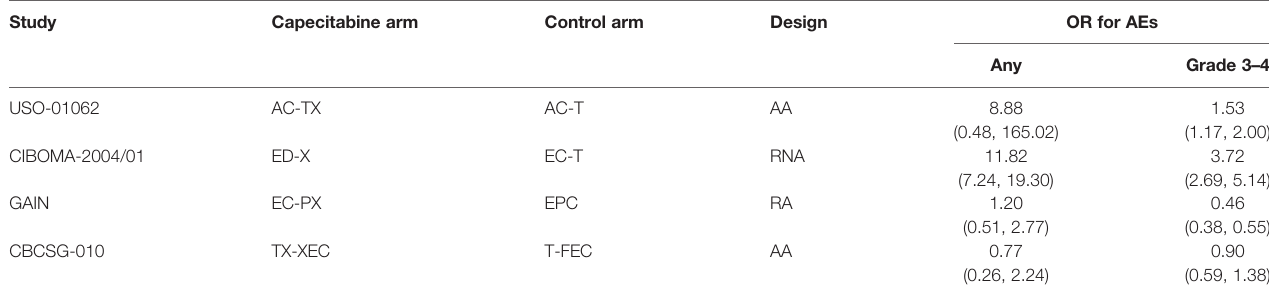
TABLE 2 | Reported odds ratios of adverse events in included studies.